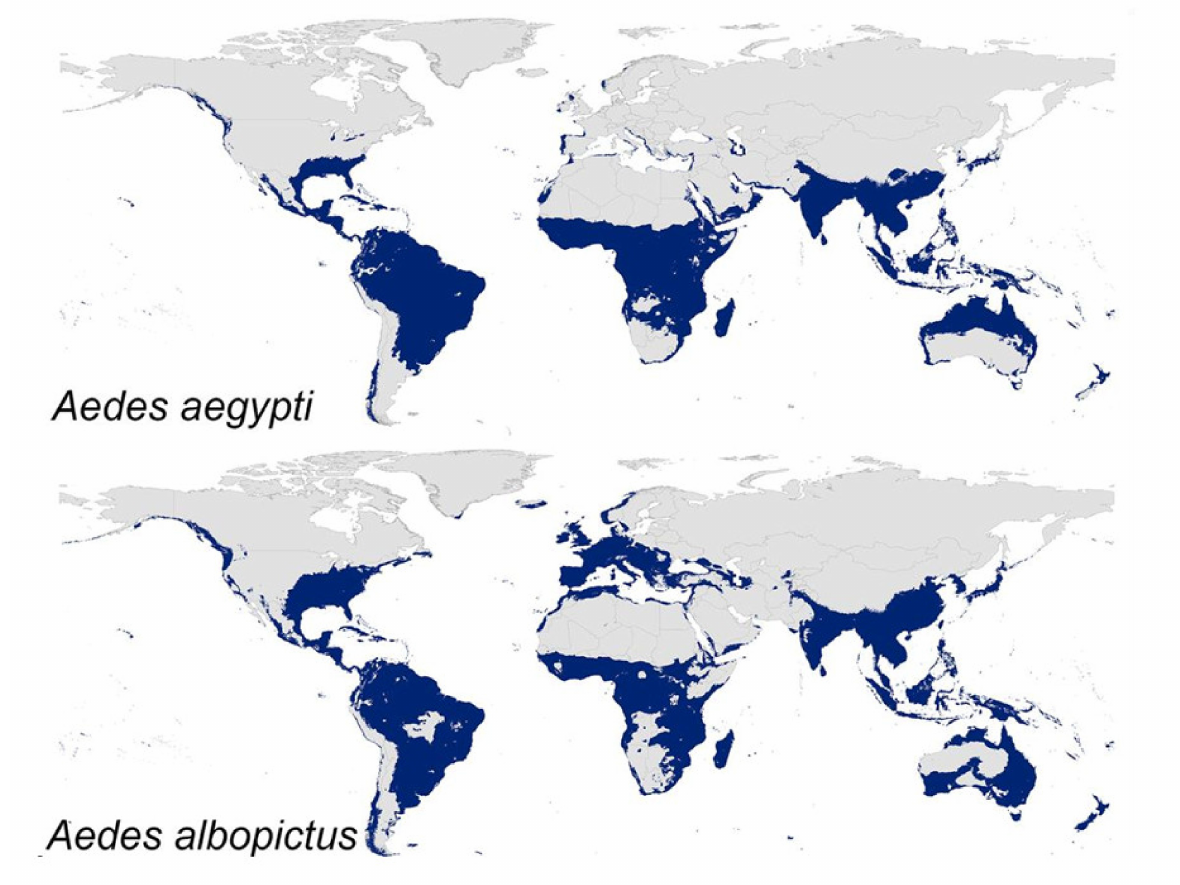
Figure 8. Potential distribution of Aedes aegypti and Aedes albopictus . This distribution is based on present climatic conditions. Blue shaded areas are projected as suitable and grey shaded regions are unfavorable. Adapted from